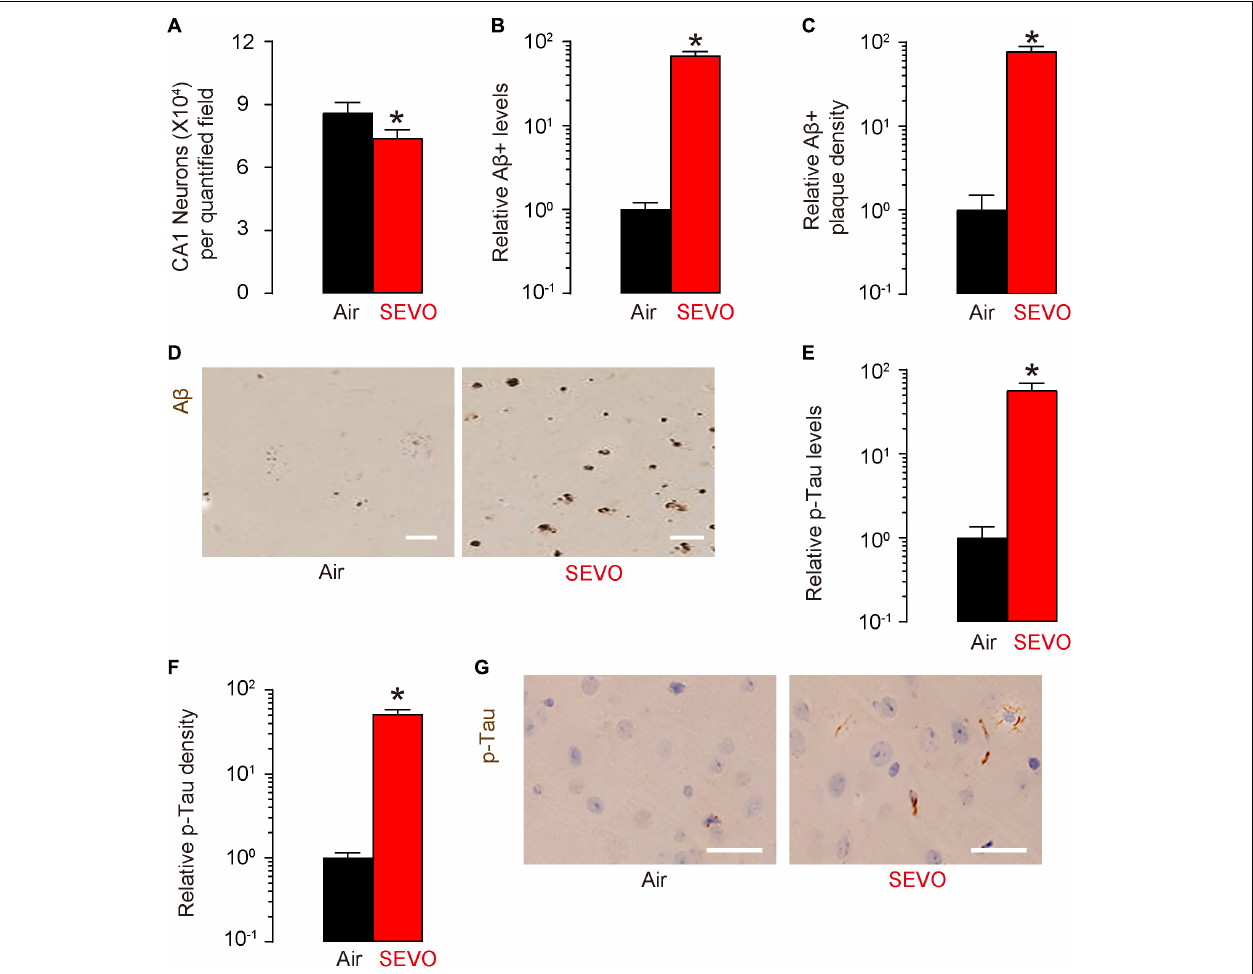
FIGURE 2 | SEVO increases loss of neuronal cells, A β deposition, and p-Tau formation in the brain of APP/PS1 mice. (A) Neuron loss in the hippocampus region of APP/PS1 mice at sacrifice (2 months after SEVO/Air exposure and at 5 months of age). (B) ELISA for A β levels in hippocampus from SEVO-exposed mice, compared to air-control mice. (C,D) A β plaque density in the hippocampus region in SEVO-exposed mice, compared to air-control mice, shown by quantification (C) and by representative images (D) . (E) ELISA for p-Tau levels in hippocampus from SEVO-exposed mice, compared to air-control mice. (F,G) p-Tau density in the hippocampus region in SEVO-exposed mice, compared to air-control mice, shown by quantification (F) and by representative images (G) . * p < 0.05. N = 10. N represents mouse number per experimental group. Scale bars are 20 µ